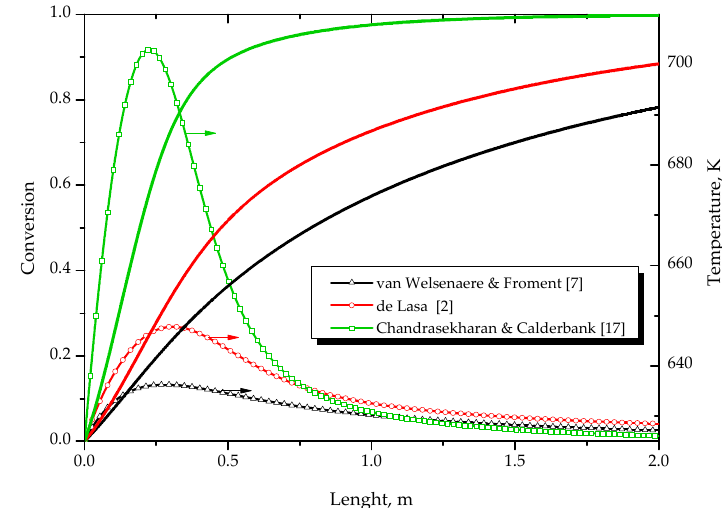
Figure 2. O-xylene conversion and reactive temperature profiles obtained with a one-dimensional Packed Bed Tubular Reactor (PBR) model using three different kinetic models.